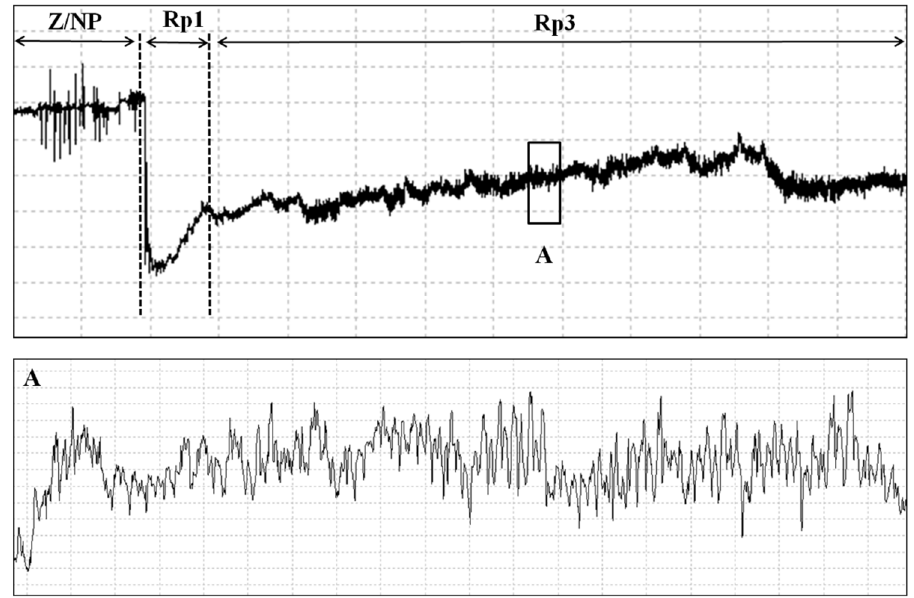
Figure 2. Waveforms generated using EPG for R. pedestris on pod and cotyledon of soybean. Box A enlarged view of detail of waveform Rp3.